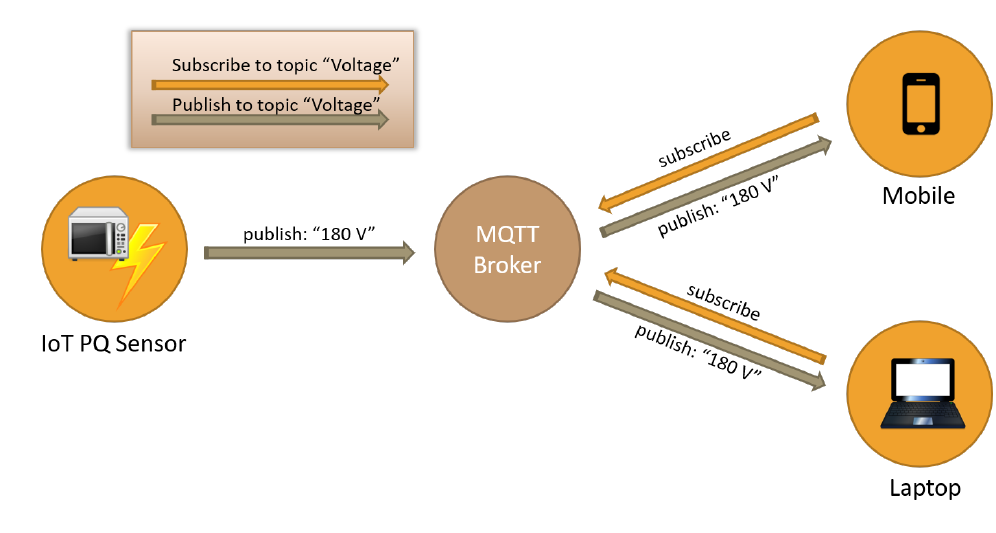
Figure 12. Publish to a channel field feed.